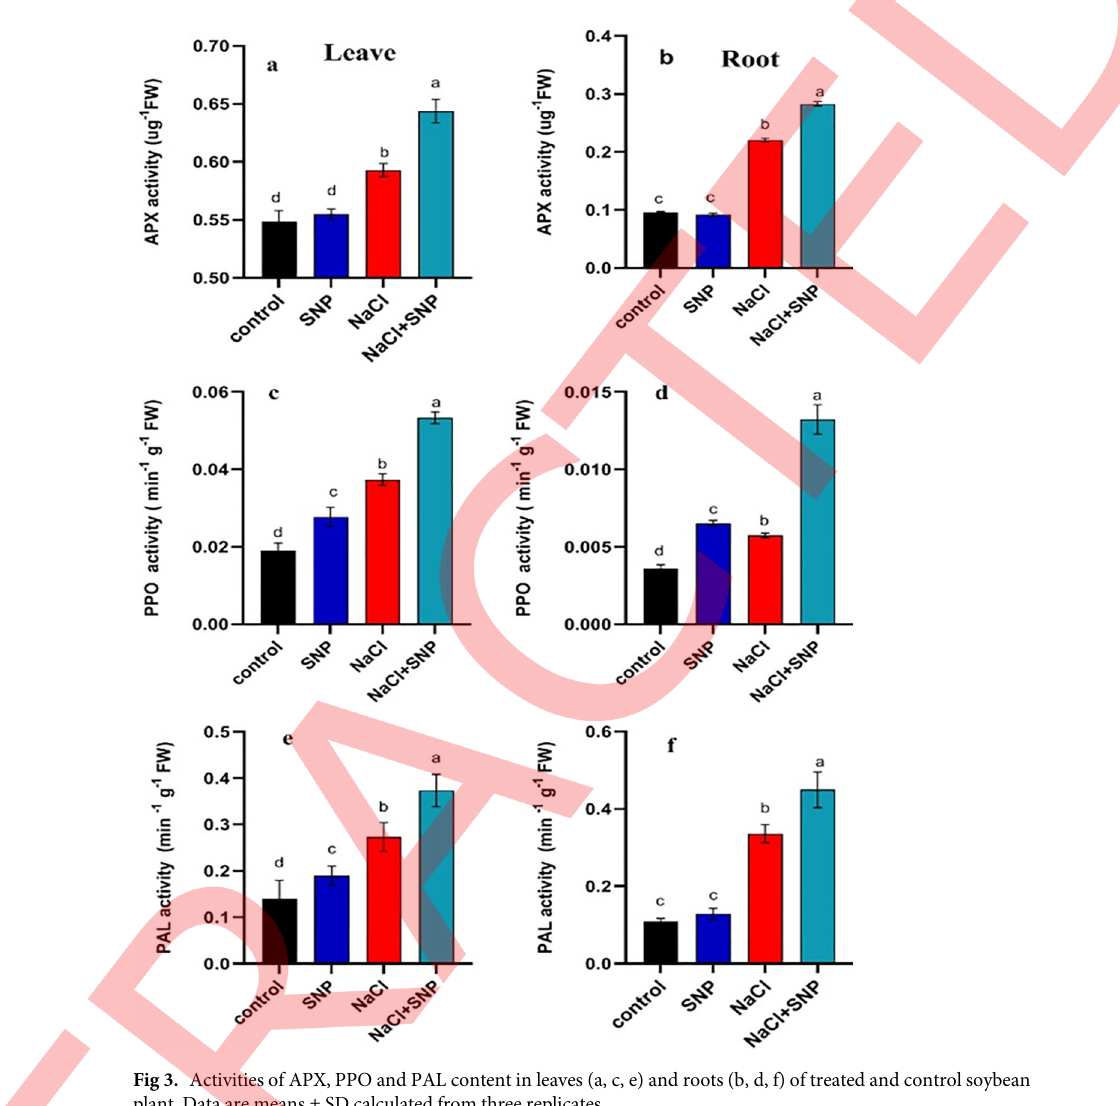
Fig 3. Activities of APX, PPO and PAL content in leaves (a, c, e) and roots (b, d, f) of treated and control soybean plant. Data are means ± SD calculated from three replicates.